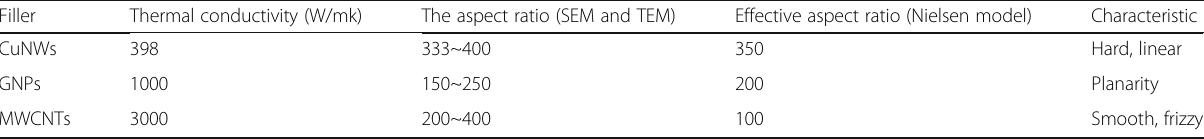
Table 1 The physical properties and aspect ratio of three kinds of fillers Filler Thermal conductivity